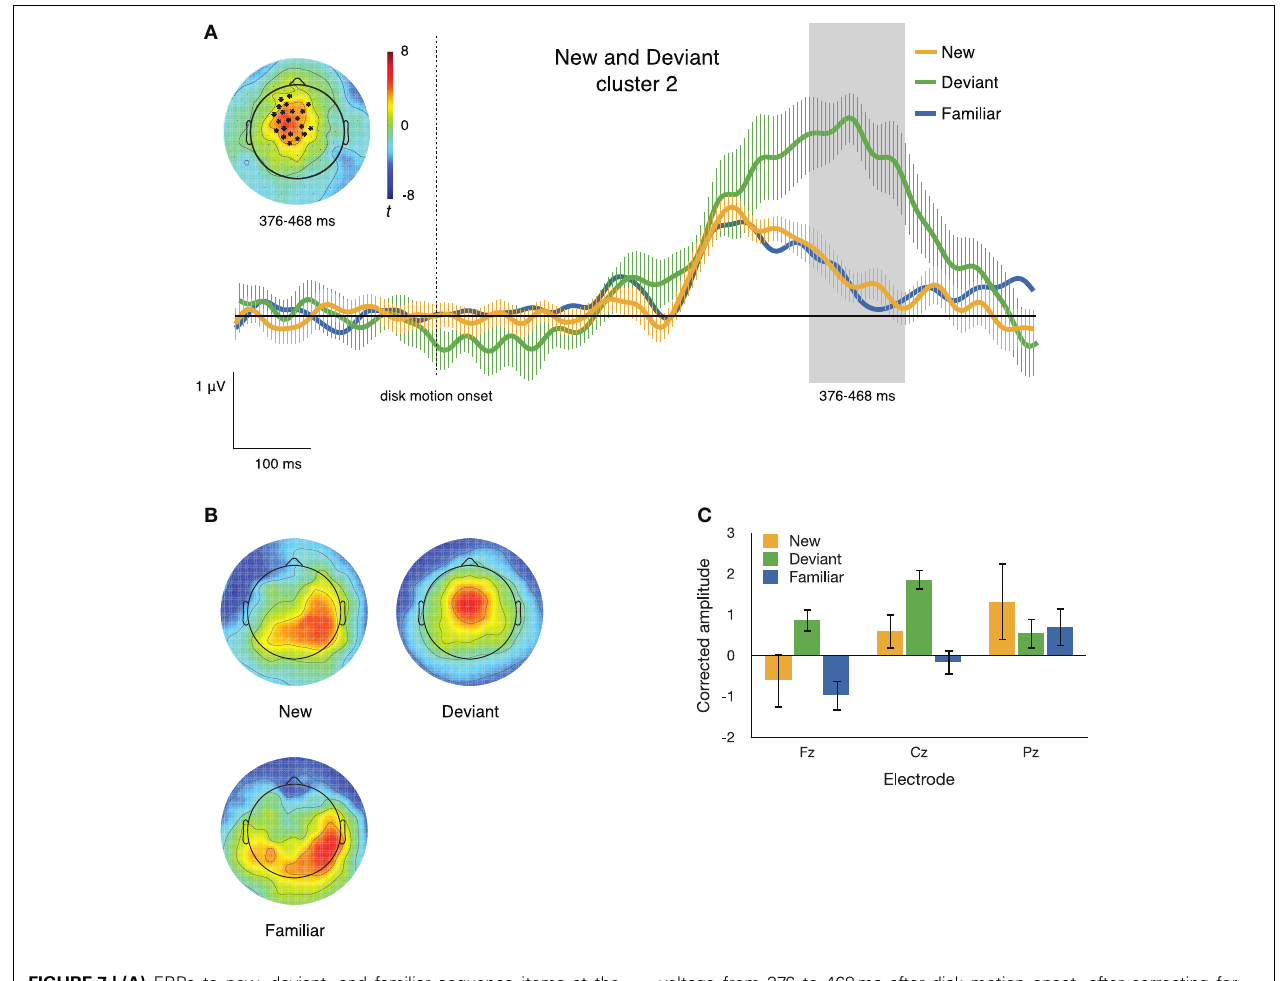
voltage from 376 to 468ms after disk motion onset, after correcting for overall amplitude differences between conditions. Deviant items appear to elicit markedly different topographies from new items. (C) Mean corrected amplitude from 376 to 468ms after disk motion onset, at three midline electrodes. There is a significant interaction between electrode and